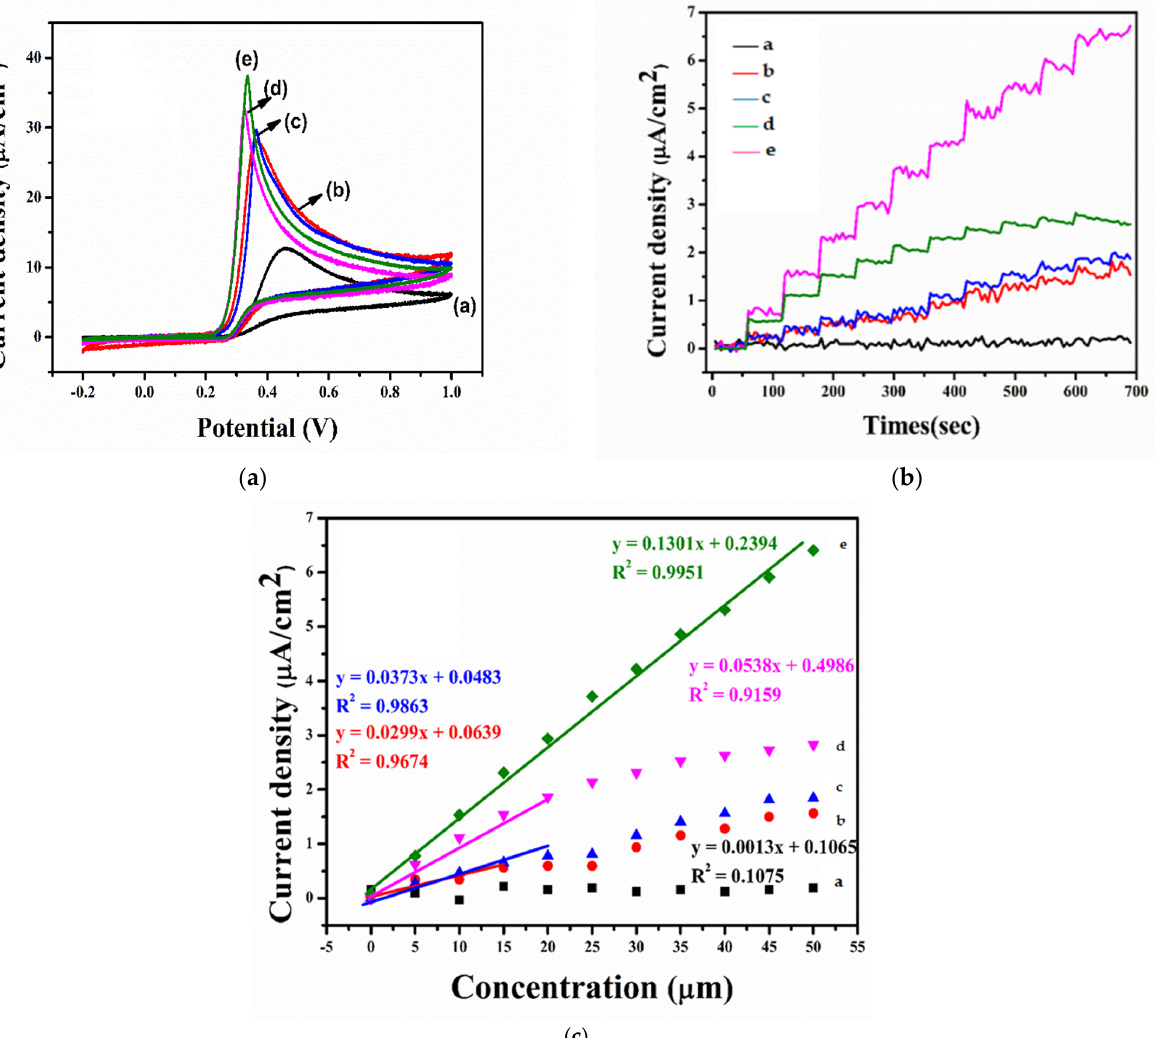
Figure 7. ( a ) Cyclic voltammograms of CPE (a), EPI (b), EPIS (c), EPIP (d), and EPIG (e) modified electrodes in PBS (pH~7) with 350 µ M UA concentrations with scan rate of 50 mV · s − 1 . ( b ) Typical Amperometric response obtained with CPE (a), EPI (b), EPIS (c), EPIP (d), and EPIG (e) modified electrode at 310 mV with successive additions of AA into 30 mL of PBS. ( c ) The corresponding calibration plot for current density vs. [UA] of CPE (a), EPI (b), EPIS (c), EPIP (d), and EPIG (e) modified electrodes.